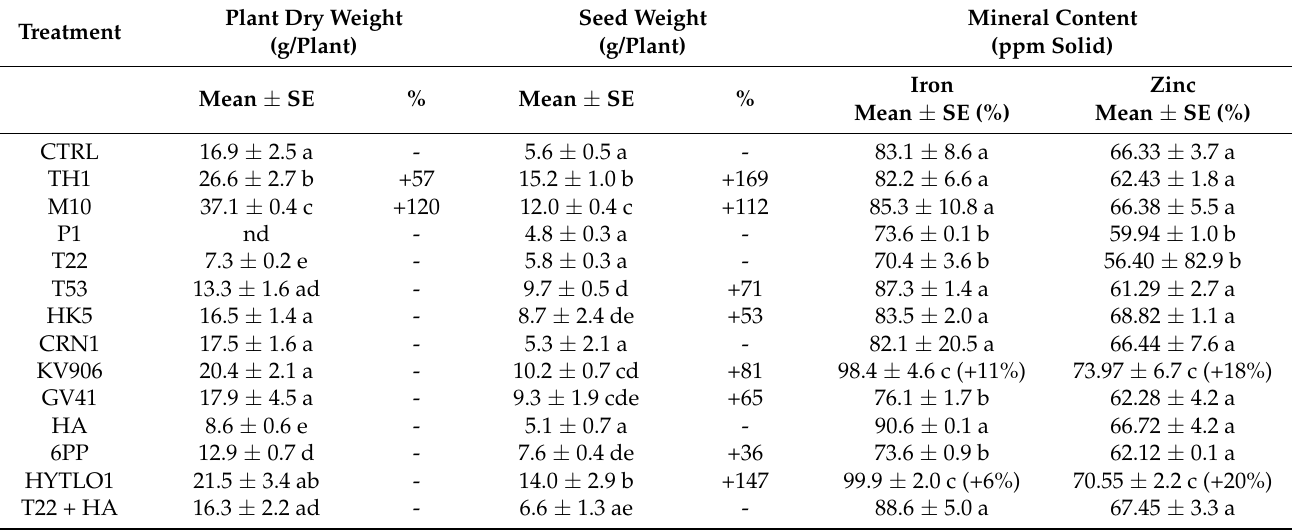
Table 7. Effects of Trichoderma strains (TH1, M10, P1, T22, T53, HK5, CRN1, KV906 or GV41) or metabolites (HA, 6PP, HYTLO1), applied singly as seed coating, on the lentil mineral content. Plants were grown in field conditions and water treatments served as controls (CTRL). Data represent the mean value of three biological replicates (each one consisting of 10 plants) ± standard error (SE). Different letters in a column indicate statistically significant differences for p < 0.05. Significant increments compared with control (CTRL) are reported as %; nd: Not